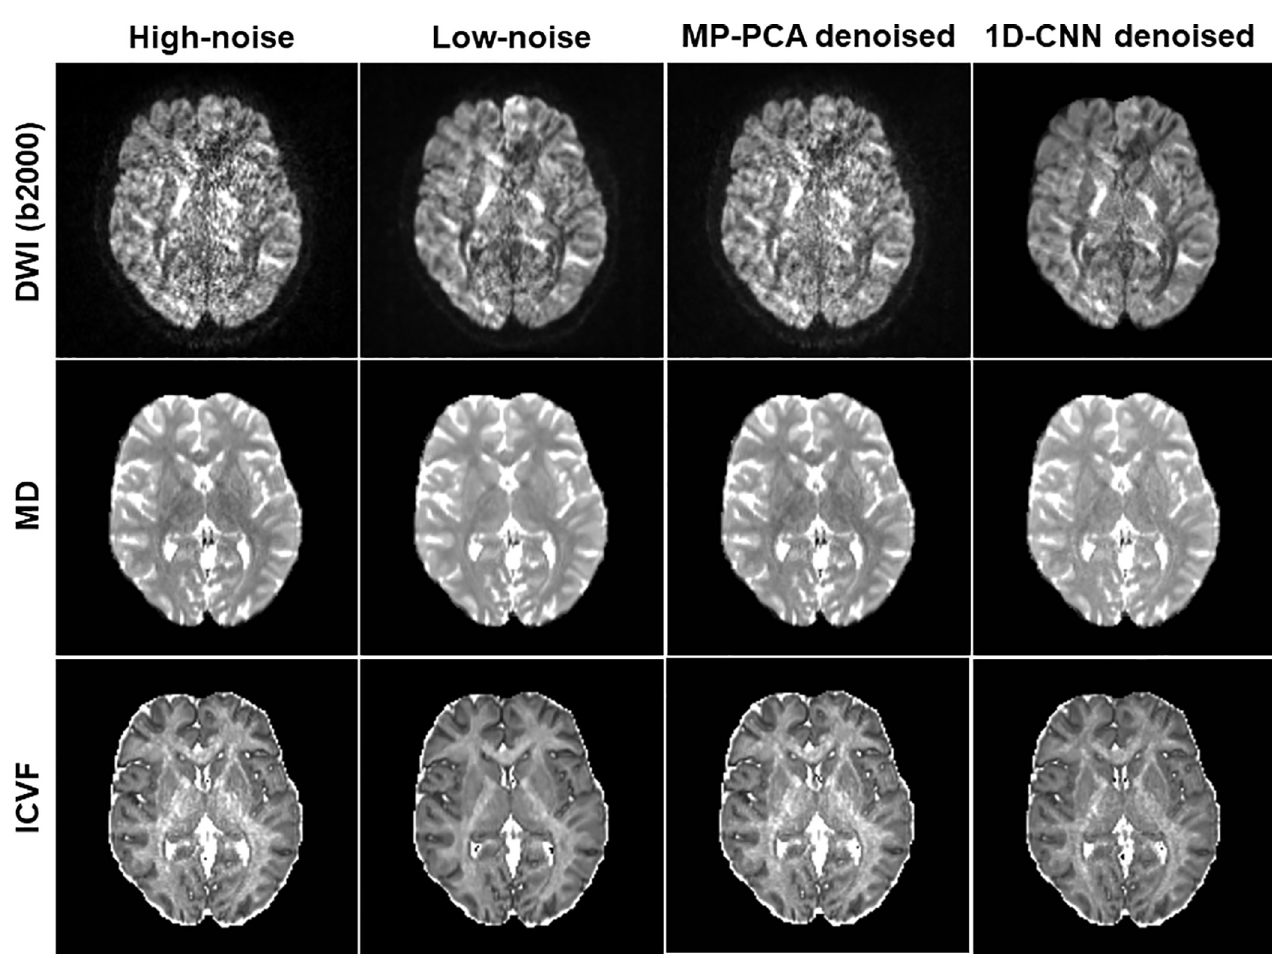
Fig 8. The original high-noise image, low-noise image, and denoised images using MP-PCA and 1D-CNN along with derived MD and ICVF maps of a representative slice in Experiment 1 (iPAT2 vs. iPAT1) for b-value 2500 s/mm 2 .